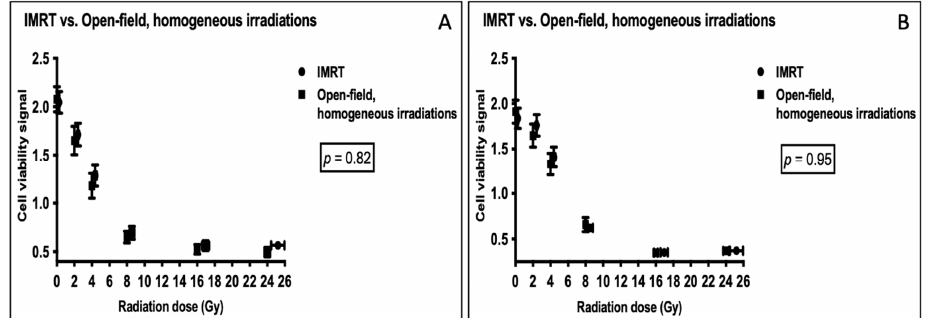
Figure 4. ( A ) Comparison of A375 cell viability signal between 96-well tissue culture plate IMRT and open-field, homogeneous irradiations ( p = 0.82). ( B ) Comparison of LN18 cell viability signal